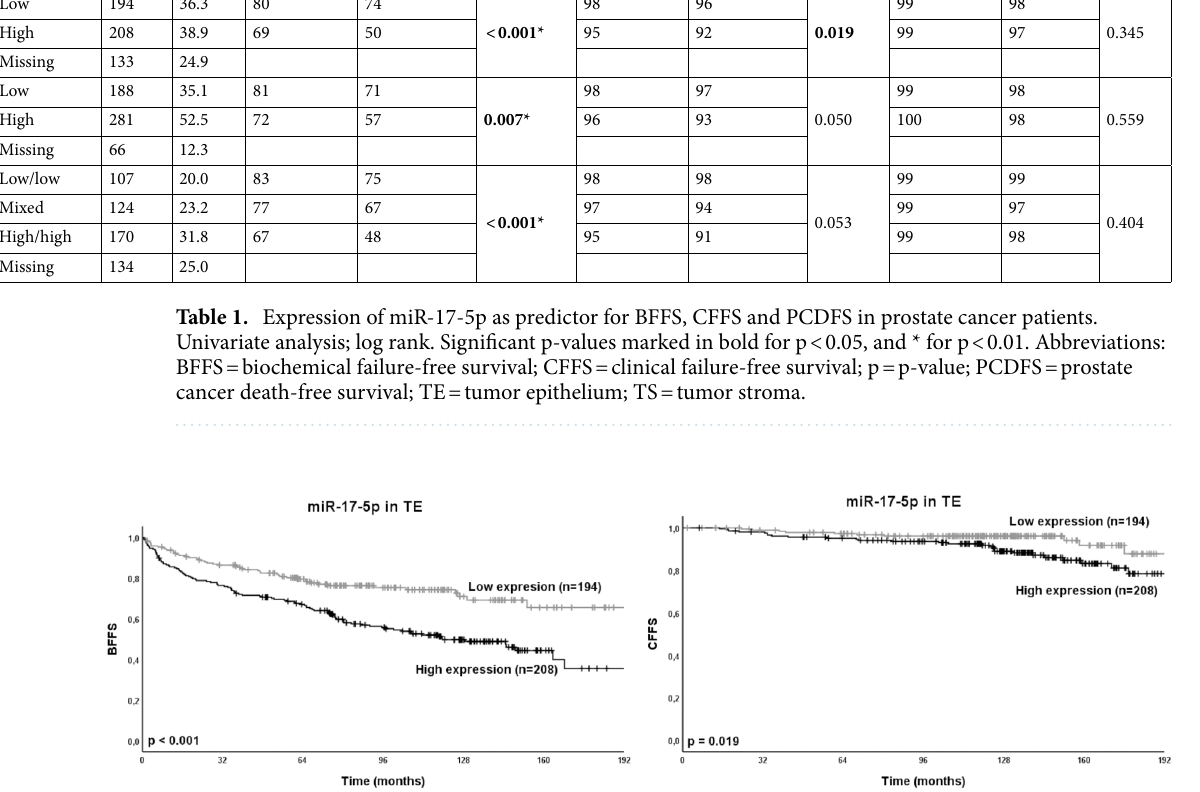
Figure 3. Relation between miR-17-5p in TE and the prostate cancer outcomes BFFS and CFFS presented in Kaplan–Meier curves. miR-17-5p was divided into low and high expression for the 402 available